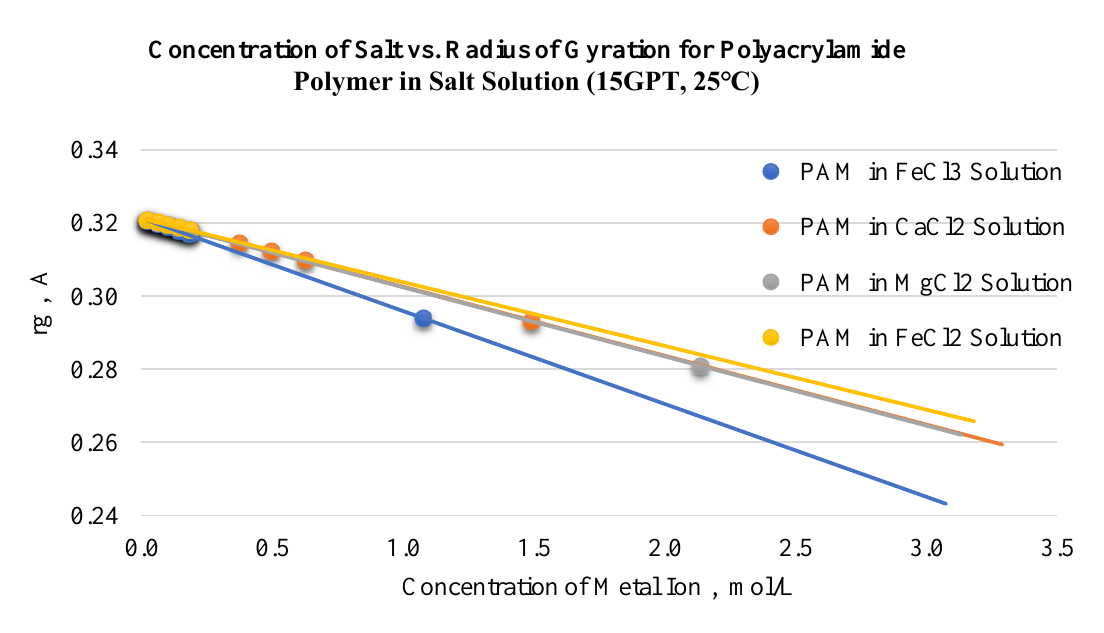
Figure 7—Radius of gyration evolution as PAM interacts with various metal ions in different